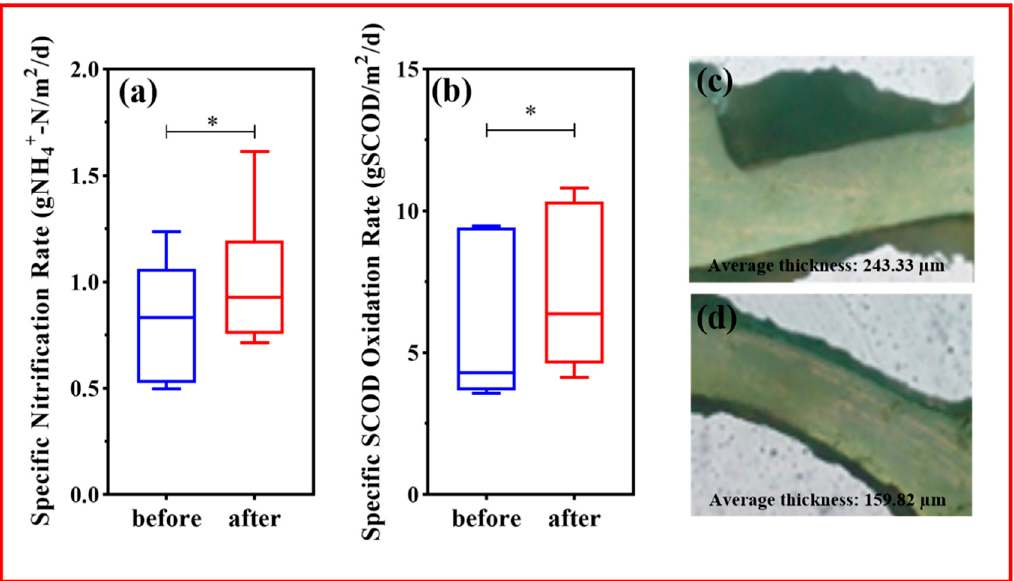
Figure 4. The average nitrification rate before and after cycle cleaning process ( p = 0.037, n = 7) ( a ), the average soluble chemical oxygen demand (SCOD) removal rate before and after cycle cleaning process ( p = 0.044, n = 7) ( b ), digital photo of biofilm before cycle cleaning ( c ), and digital photo of biofilm after cycle cleaning process ( d ).